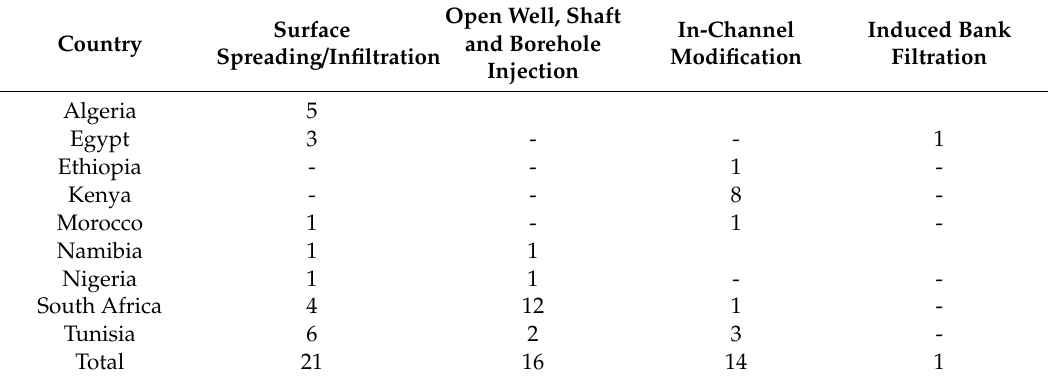
Table 2. Number of main MAR types per country.